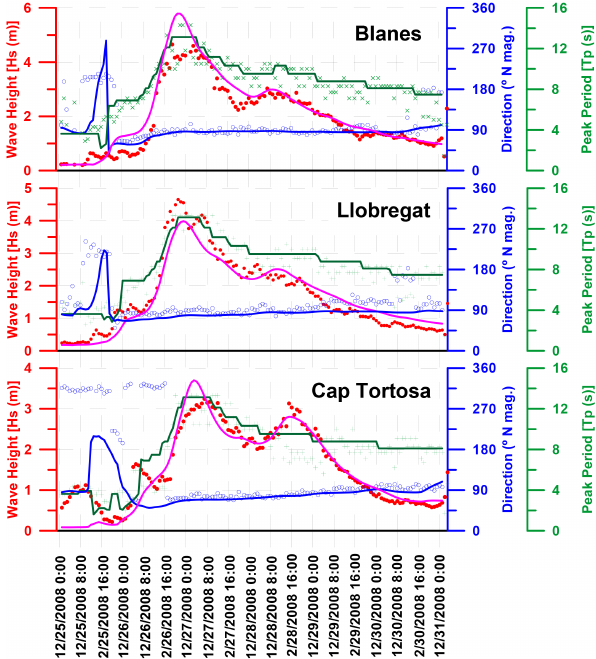
Figure 2. Intercomparison of the recorded (XIOM network) and calculated wave parameters near the coast (Llobregat buoy, moored at 45m; Blanes buoy, moored at 75m and Cap Tortosa buoy, moored at 60m). Magenta solid line: computed wave height. Blue solid line: Computed direction. Green solid line: computed peak period. Red dots: XIOM wave height. Green crosses: XIOM peak period. Blue circles: XIOM wave